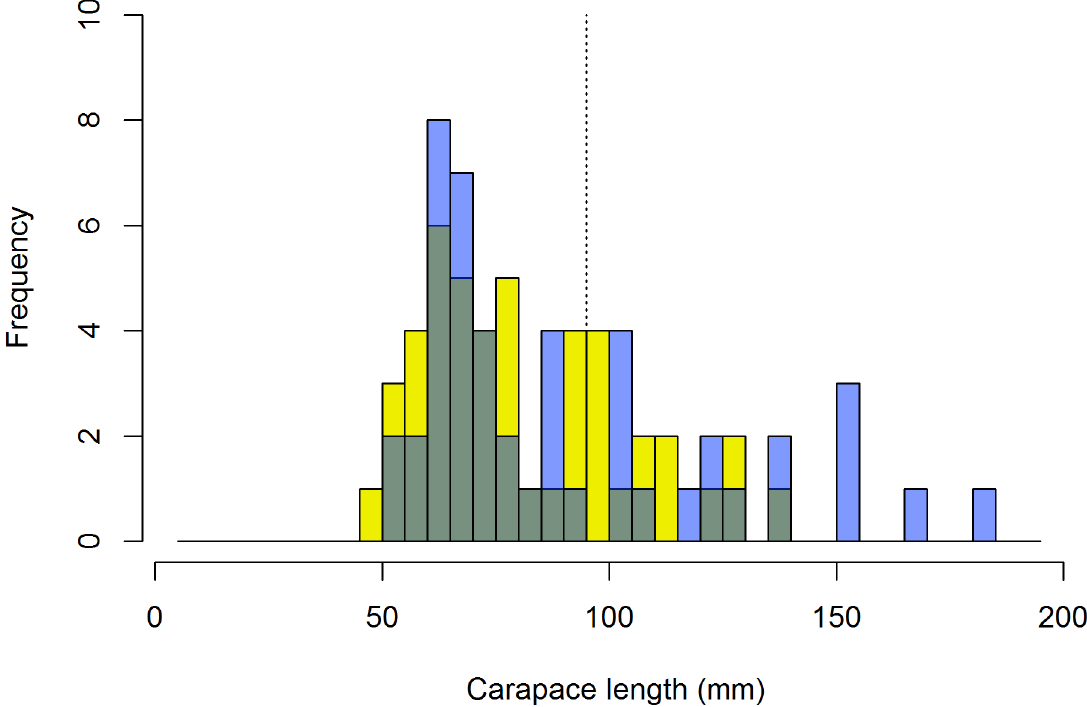
Fig 2. Size frequency histogram of lobster data. Light blue bars represent males, yellow bars represent females, and gray bars represent overlap. The vertical dashed line is at 95 mm carapacelength, the minimum legal size in Barbuda.